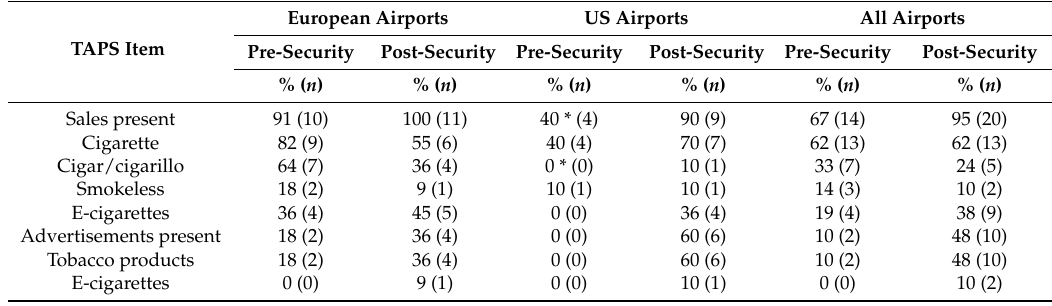
Table 1. Presence of TAPS observed in airports in Europe and the US, by location, 2014.